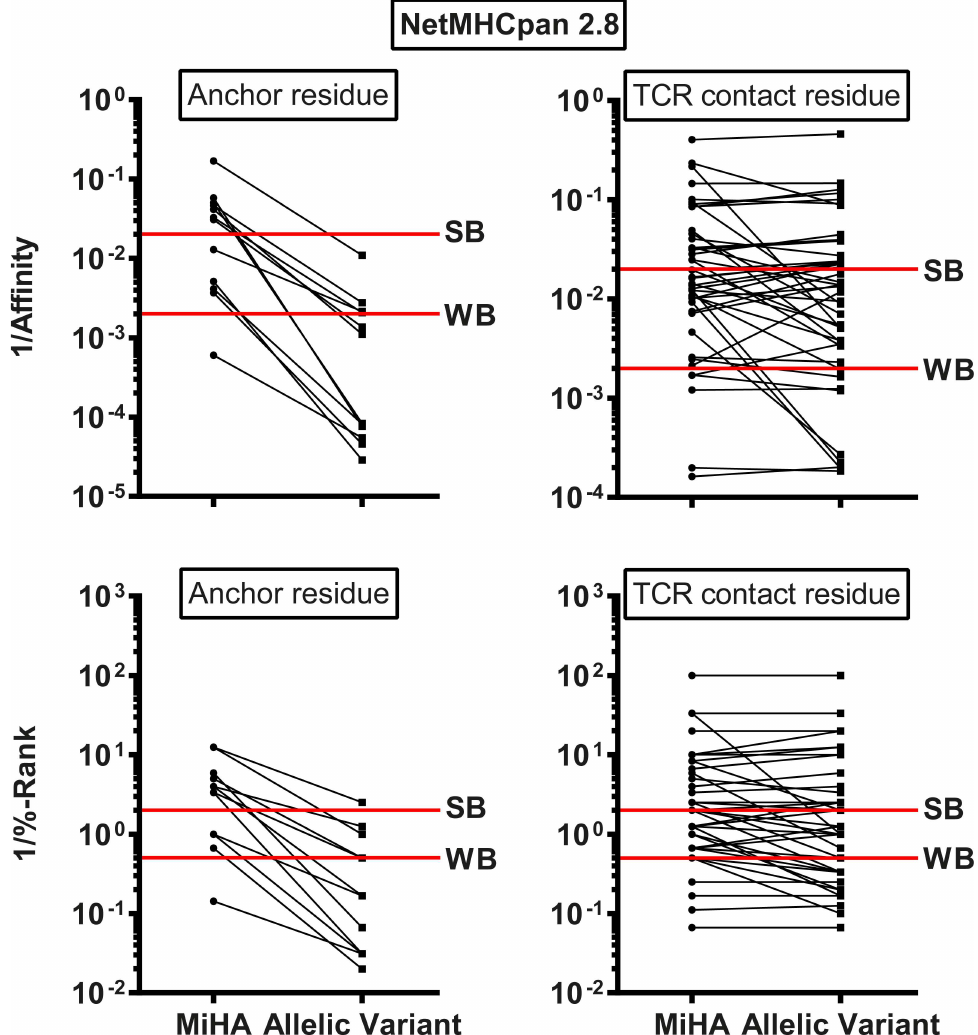
Fig 4. PredictedHLA class I bindingaffinityfor MiHAand allelicvariants. HLA class I bindingaffinityas predictedfor MiHA and their allelic variantsby NetMHCpan 2.8. Predictedaffinity(1/affinity(nM);upper)and %-Rank(1/%-Rank;lower) are shown for all MiHA with allelic variants(n = 57) divided into two groups based on whether the polymorphicamino acid is an anchor residue(n = 12; left)or TCR contactresidue(n = 45; right). Default thresholds for SB and WB peptidesare indicated by red lines. The data show that predictedHLA class I bindingfor the 12 MiHA with polymorphicamino acids at anchor positions was significantlyhigherthan for their allelicvariants(p = 0.0005 using Wilcoxon signed rank test).For the MiHA with polymorphicamino acids at TCR contact residues(n = 45), predictedHLA class I bindingas comparedto theirallelic variantswas higherfor 9 MiHA with the variant residueimmediately adjacentto the anchorat position2 (p = 0.0039 using Wilcoxon signedrank test),but similarfor the remaining 36 antigens(p = 0.1965using Wilcoxon signedrank